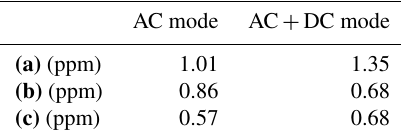
Table 2. Average XCO 2 daily SD after (a) no filtering, (b) SNR filtering, and (c) both SNR filtering and SI filtering during the AC mode and AC + DC mode periods. Only those measurements recorded within the ± 1h window around local noon are